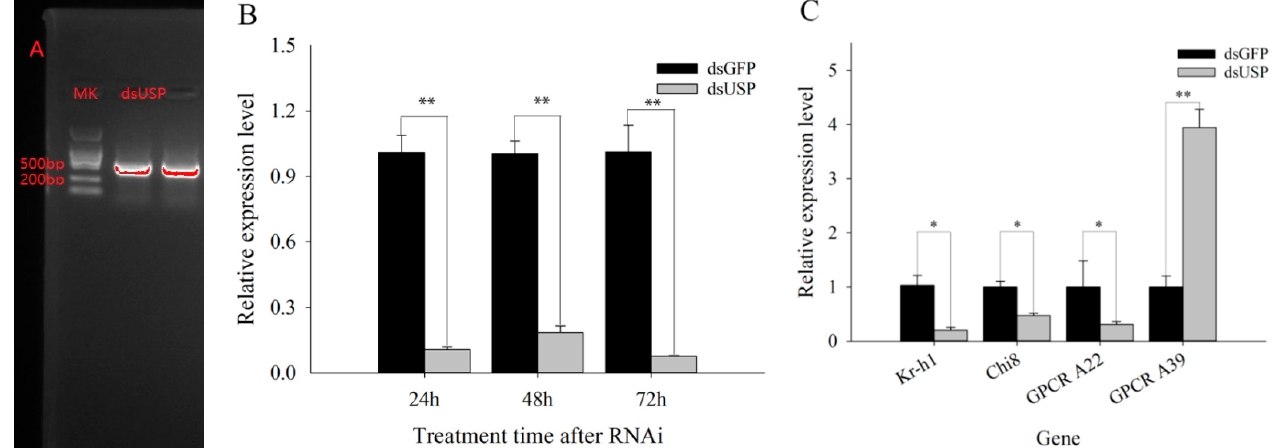
Figure 3. The relative expression levels of genes after USP was knocked down by RNAi. ( A ) Gel electrophoresis of ds USP . ( B ) Relative expression level of USP. ( C ) Relative expression levels of growth- and development-related genes in nymphs after RNAi. * and ** show significance at p < 0.05 and 0.01 levels with Student’s t -test, respectively.